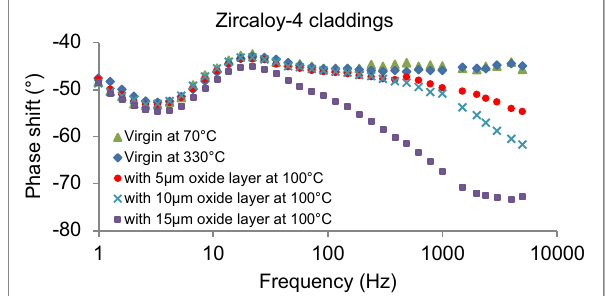
Fig. 7. Phase shifts for Zy4 claddings as a function of modulated frequency.